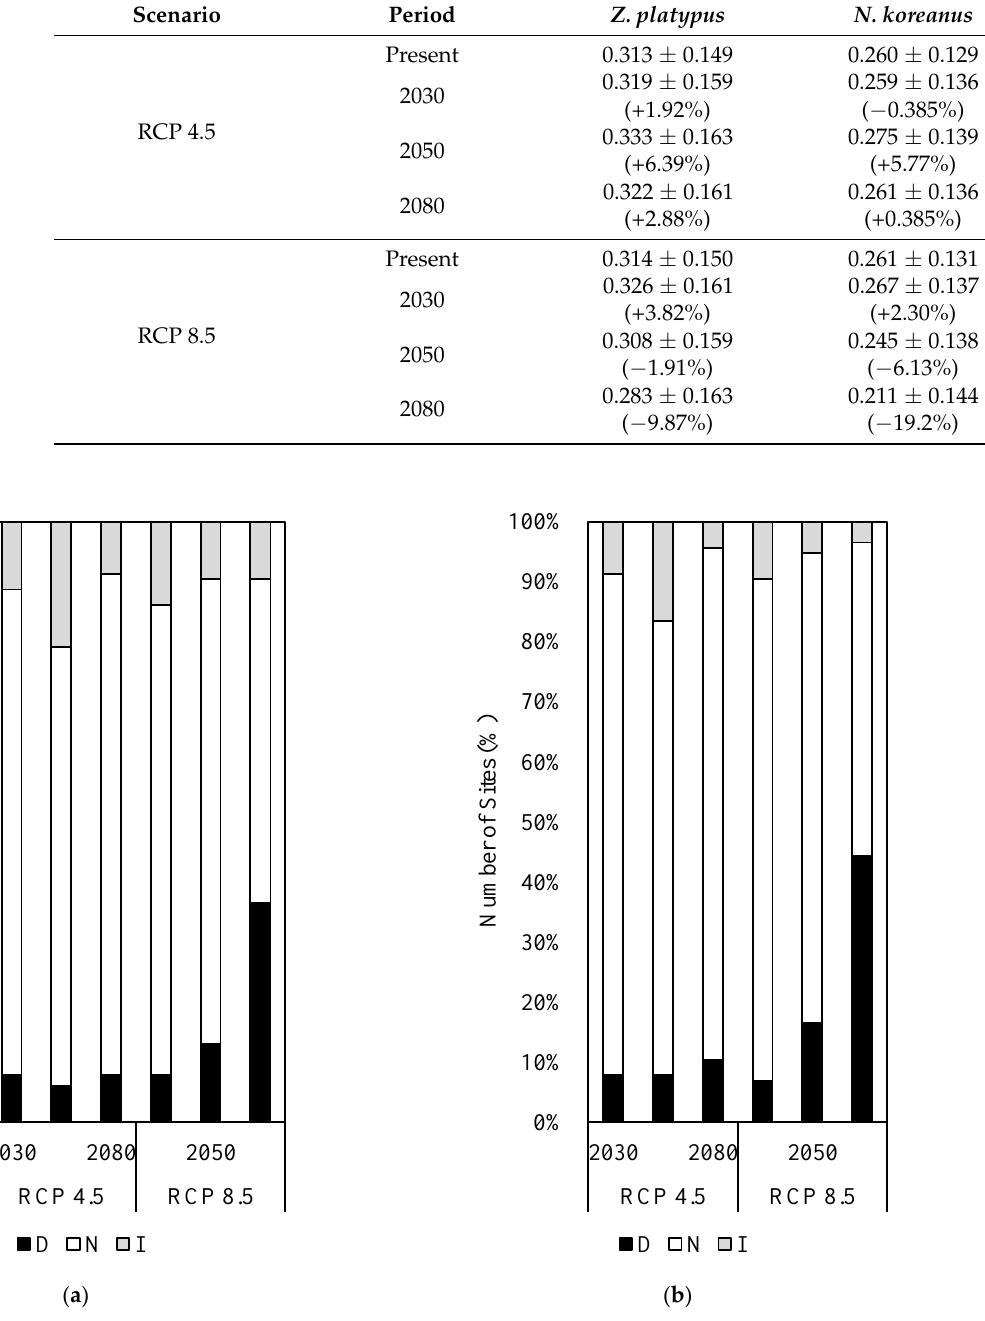
Figure 5. Percentage of study sites (total 115) where present ecological habitat suitability (EHS; n = 8) for ( a ) Zacco platypus and ( b ) Nipponocypris koreanus is significantly different ( p < 0.05) from future EHS (n = 10) according to ANOVA (D: decrease, N: no difference, and I: increase). Meanwhile, at most sites (52.2 – 85.2%), future EHS under the RCP 4.5 and RCP 8.5 scenarios was not significantly different ( p ≥ 0.05) from present EHS. Simultaneous in- crease in growth (GI increase) and stress (SI decrease) with global warming (Table S4) may result in negligible effect of climate change on EHS. In addition, HHS decrease may be compensated by PHS increase (Table S3), likely leading to the insignificant change in EHS under climate change. Similarly, Zhang et al. [27] demonstrated that C. guichenoti will benefit from global warming through extended spawning periods and enhanced habitat conditions for juveniles. Moreover, Morid et al. [25] predicted that increased water tem- perature will offset beneficial flow conditions decreasing Z . temminickii habitat suitability in summer, while Z. platypus and Z. temminickii were predicted to benefit from increased water temperature in winter regardless of altered flow. 3.2. Identification of Major Environmental Factors Partial correlation analysis was used to identify the relationship between environ- mental variables (Table S5) and EHS of Z. platypus and N. koreanus (Table 1). Changes in depth (ΔDepth), average water temperature (ΔWT avg ), minimum water temperature (ΔWT min ), and number of hot days (days exceeding H0; ΔHot) were significantly corre- lated ( p < 0.05) to EHS changes in both species (Table 2). Furthermore, the number of cold days (number of days exceeding C0; ΔCold) was also a significantly important factor ( p < 0.05) for N. koreanus . Except for ΔDepth, they are environmental variables related to water temperature that affects fish growth and stress.